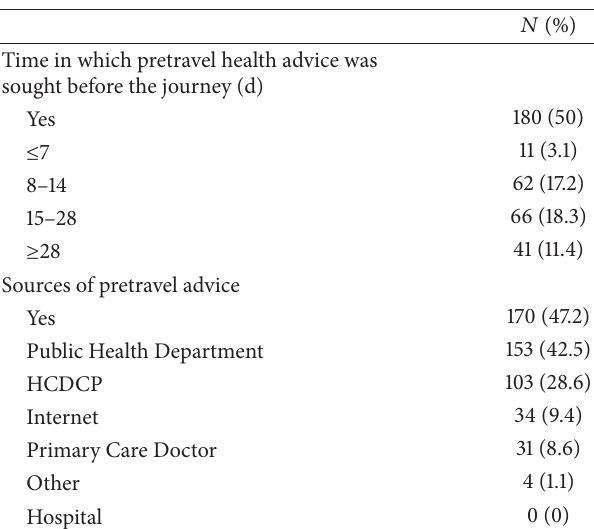
Table 1: Characteristics of travelers to African countries and pretravel health advice ( 𝑁 = 360